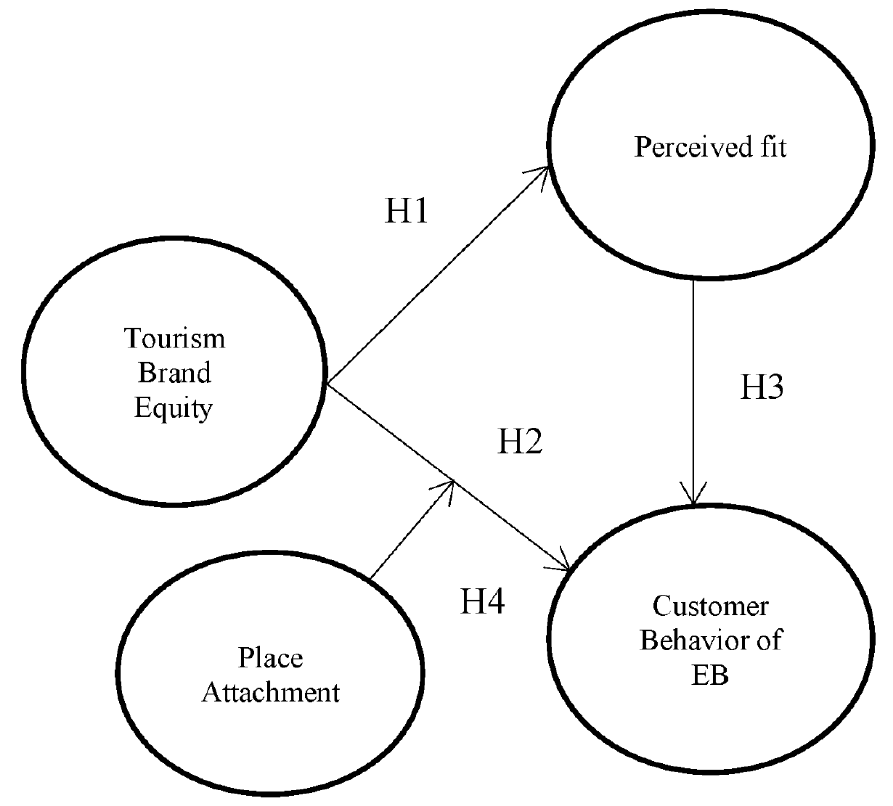
Figure 1. Research model.